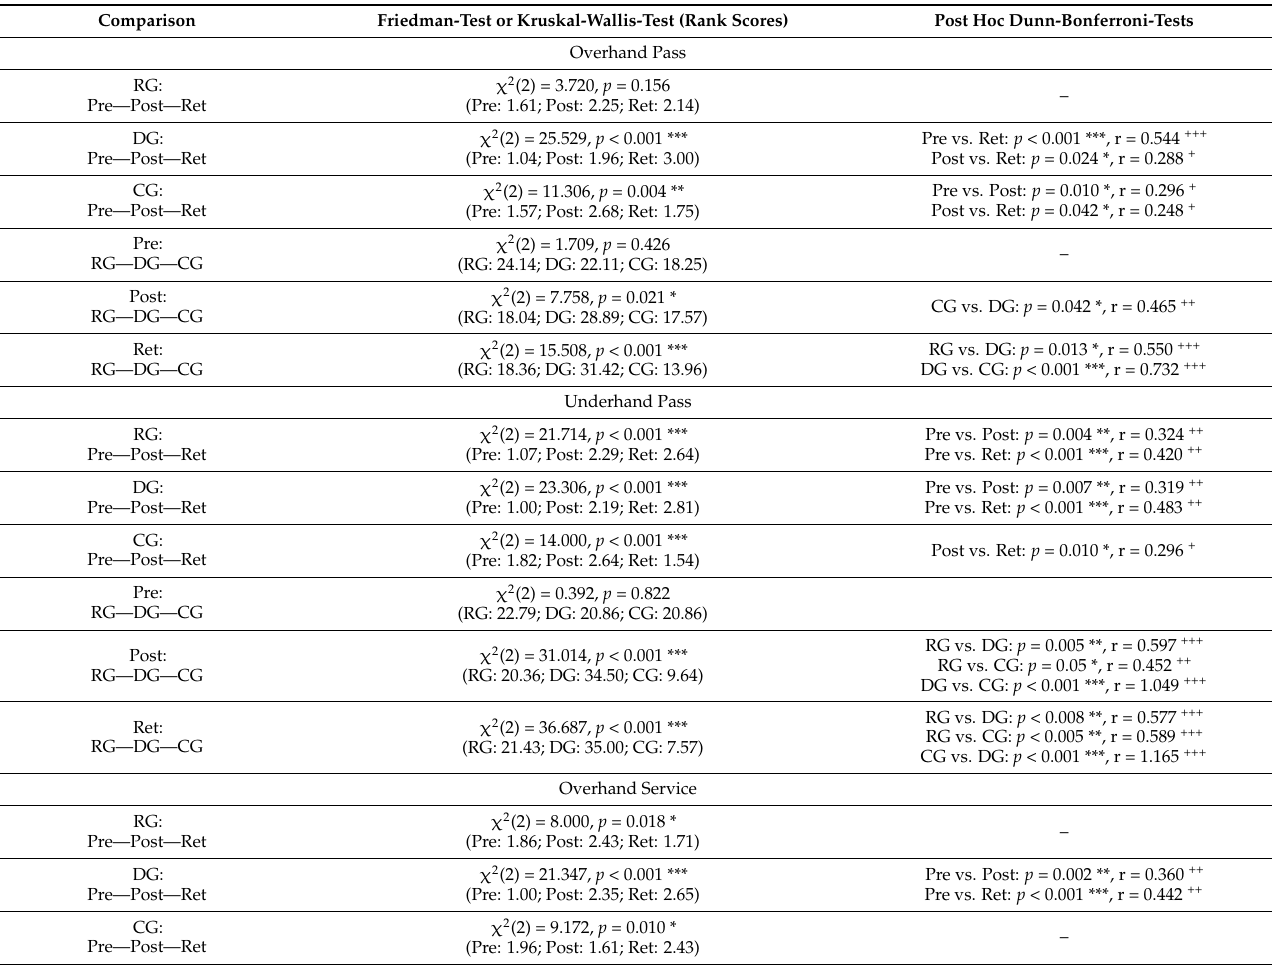
Table 1. Statistical comparisons at the three measurement time points within and between groups. Comparison Friedman-Test or Kruskal-Wallis-Test (Rank Scores) Post Hoc Dunn-Bonferroni-Tests Overhand